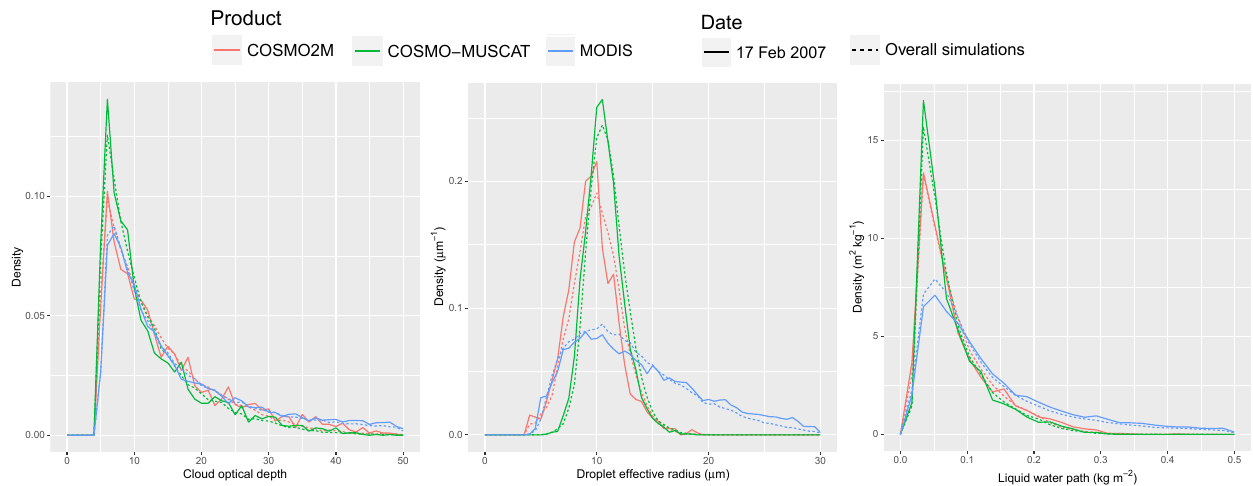
Figure 5. Probability density functions (PDFs) of cloud optical depth, cloud effective radius, liquid water path from COSMO-MUSCAT (green), COSMO2M (red), and MODIS level-2 products (blue) for 17 February 2007 (solid line) and for a 10-day (15–24 February 2007) simulation period (dashed